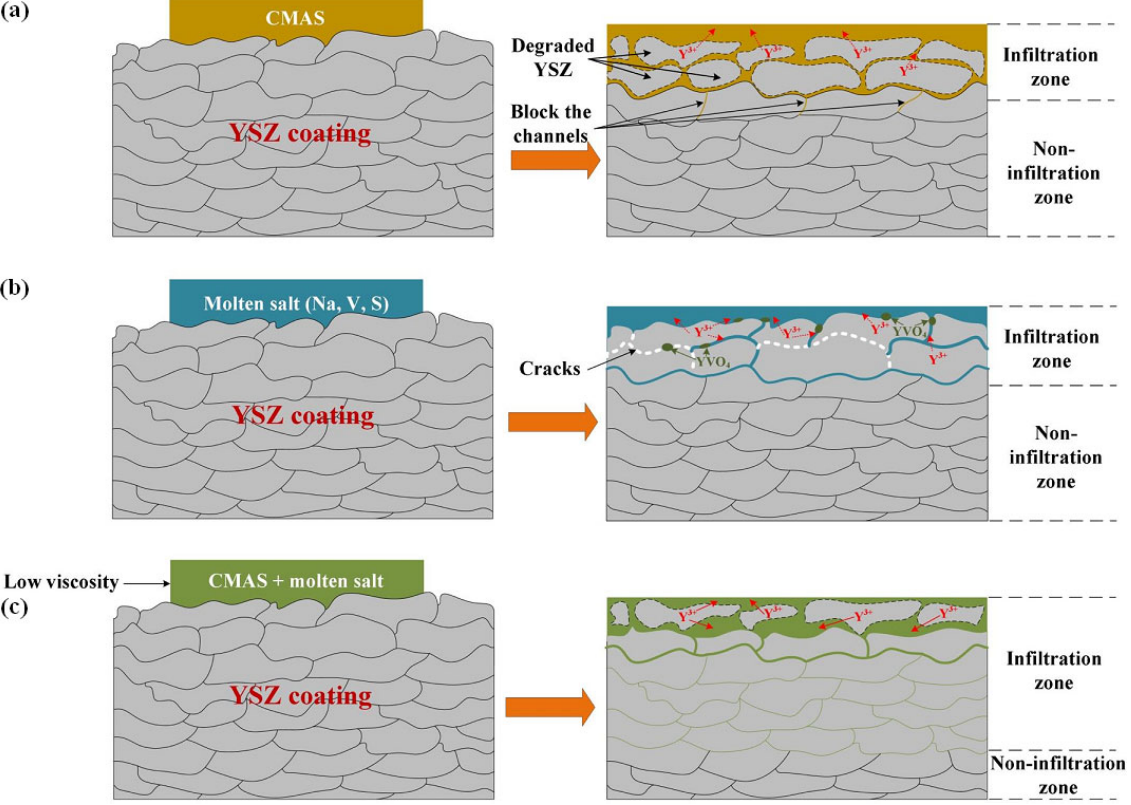
Fig. 55 Schematic diagram of different corrosion mechanisms for APS TBCs: (a) CMAS, (b) molten salt, and (c) CMAS + molten